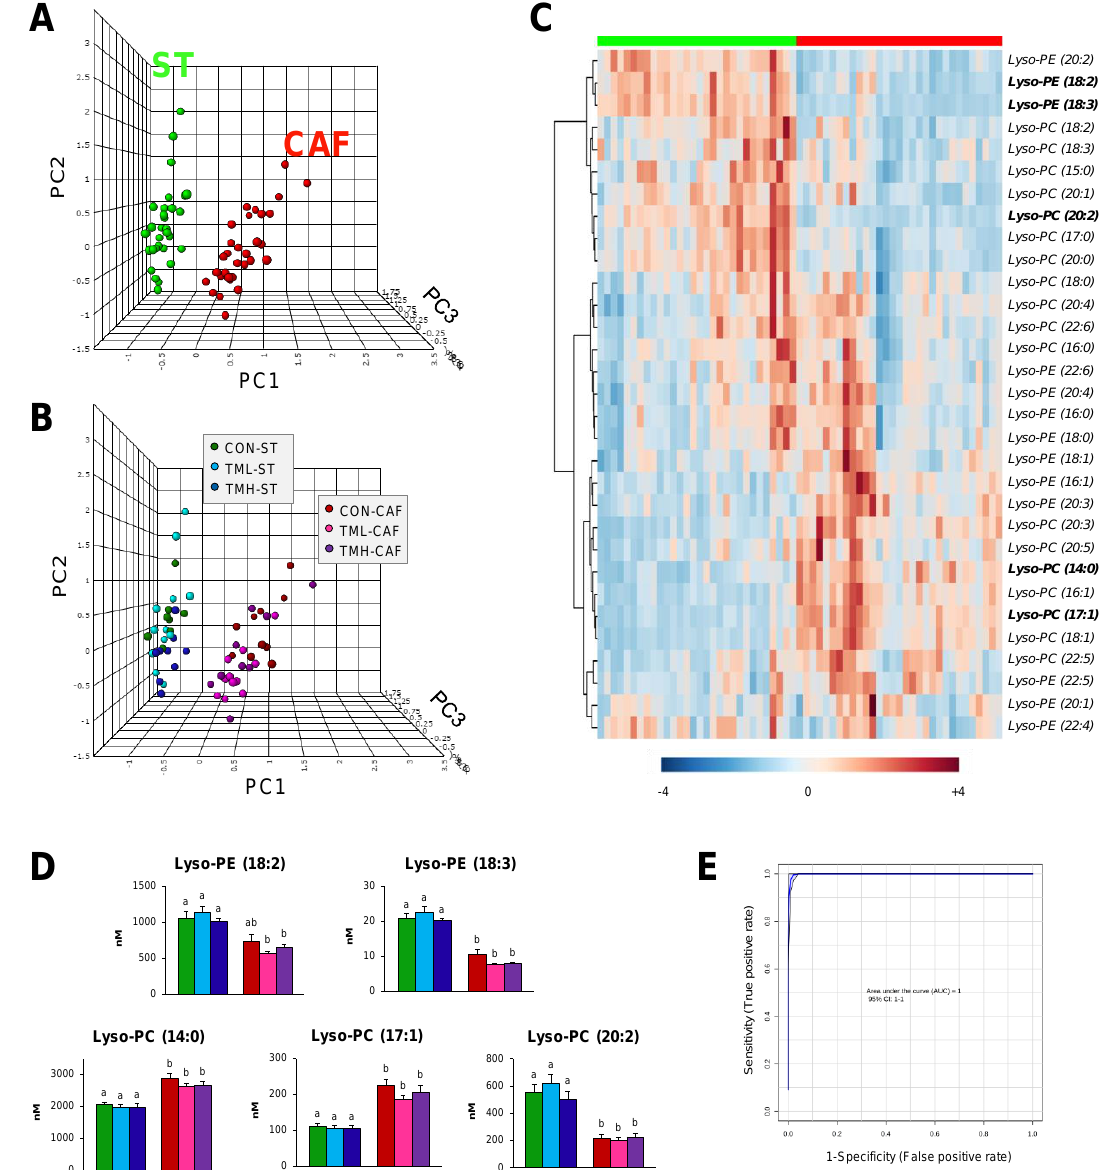
Figure 2. Identification of CAF-related biomarkers. ( A ) Three-dimensional score plot of principal component analysis (PCA) of the thirty-one Lyso-PLs quantified in rat serum. Animals fed standard chow (ST) are represented as green spots and animals fed cafeteria diet (CAF) as red spots. ( B ) Score plot shown on panel A with spots colored as ST or CAF-fed animals trained on a treadmill at different intensities (CON: 0; TML: 12; TMH: 17 m/min) for 2 months. ( C ) Heatmap plot of hierarchical clustering analysis of the Lyso-PL levels in each dietary group. Each row represents a molecular specie colored by its range-scaled abundance intensity. The scale from − 4 (blue) to +4 (red) represents this normalized abundance in arbitrary units. ( D ) Circulating levels expressed on nano molarity (nM) of the best cafeteria diet-related biomarkers in the six groups of animals ( n = 9 – 12). Mean values with different lowercase letters were significantly different (one-way ANOVA and Tukey or Dunnett’s T3 post hoc contrasts, p < 0.05). ( E ) Receiver operating characteristic (ROC) curve analysis using the five Lyso-PLs with the variable of highest importance in the discrimination of both dietary groups. The area under the curve (AUC) and the corresponding confidence interval (CI) were optimal.